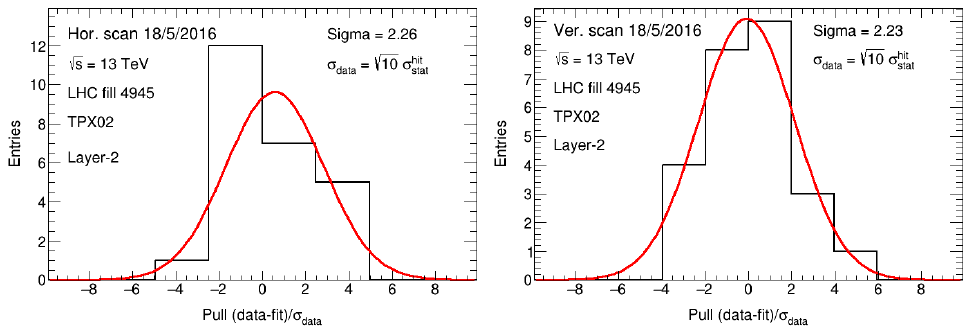
√ R · σ hit Figure 49. Pull distribution defined as (data-fit)/ σ data , where σ data = with R = N hit / N cl = 10 stat. for TPX02 layer 2. The data shown in Figure 48 are used. LHC fill 4945. Taken from Ref. [15]. For TPX02 layer 2 (27 May 2016 data), the bunch-averaged widths of the beam sizes (horizontal and vertical nominal beam separations) and their statistical uncertainties are Σ = ( 134.1 ± 0.5 ) µm and Σ = ( 120.9 ± 0.5 ) µm, respectively. x y